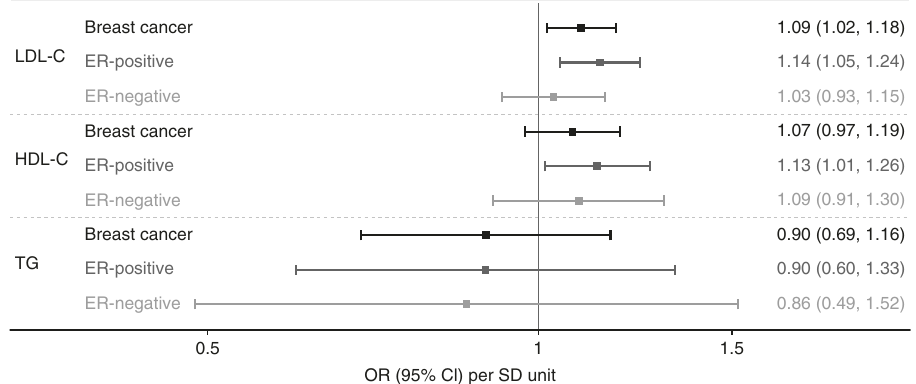
Table 7). HDL-raising variants in CETP were associated with raised breast cancer risk (OR 1.07, 95% CI, 1.03 – 1.11, P = 0.001) and ER-positive breast cancer risk (OR 1.08, 95% CI, 1.03 – 1.13, P = 0.001), although in both cases, MR Egger was suggestive of a null association (OR 1.00, 95% CI, 0.87 – 1.15, P = 0.972; and OR 1.01, 95% CI, 0.86 – 1.17, P = 0.948, respec- tively). The associations with ER-negative breast cancer risk did not reach nominal signi fi cance (OR 1.07, 95% CI, 0.99 – 1.15,